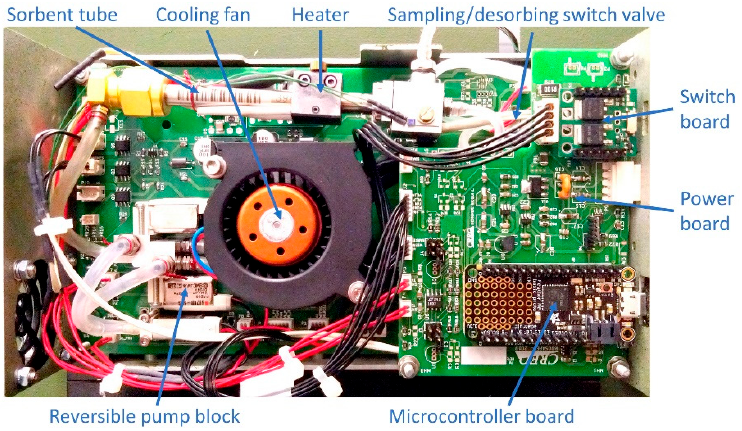
Figure 2. First stage sampling and pre-concentration module.